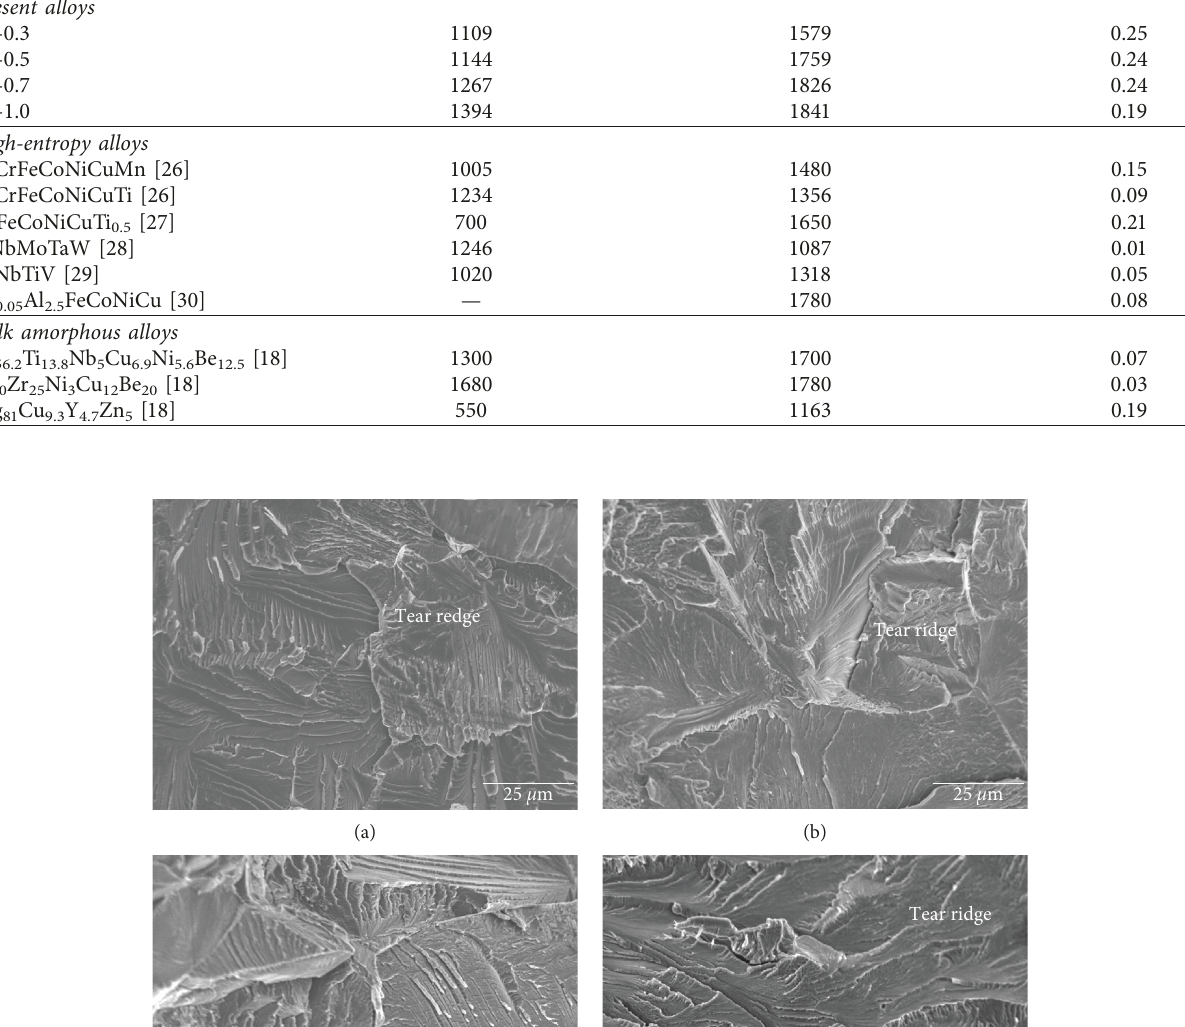
Table 2: Compressive properties of the alloys in the present study, other high-entropy alloys, and bulk amorphous alloys. Yield stress σ y (MPa) Compressive strength σ max (MPa)